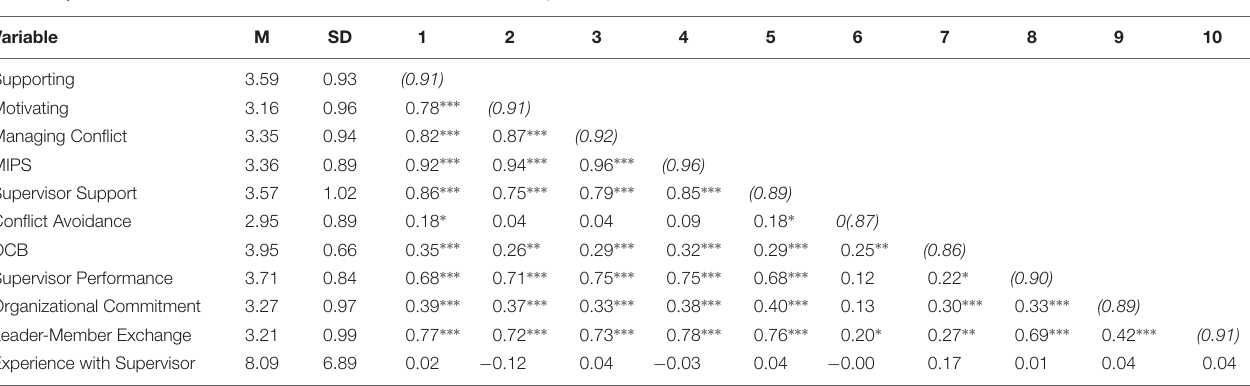
TABLE 3 | Means, standard deviations, reliabilities and correlations – Study